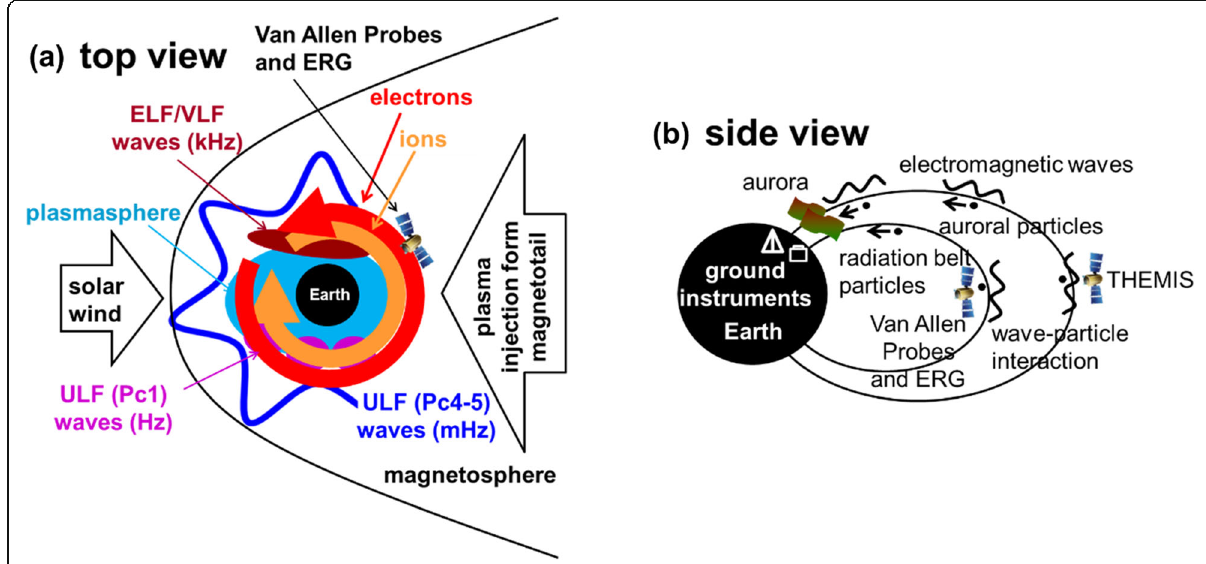
Fig. 10 Schematic picture of the energetic electron and ions and waves that interact with these particles in the inner magnetosphere around the earth. a Top view from above the north pole, and b side view from dusk to